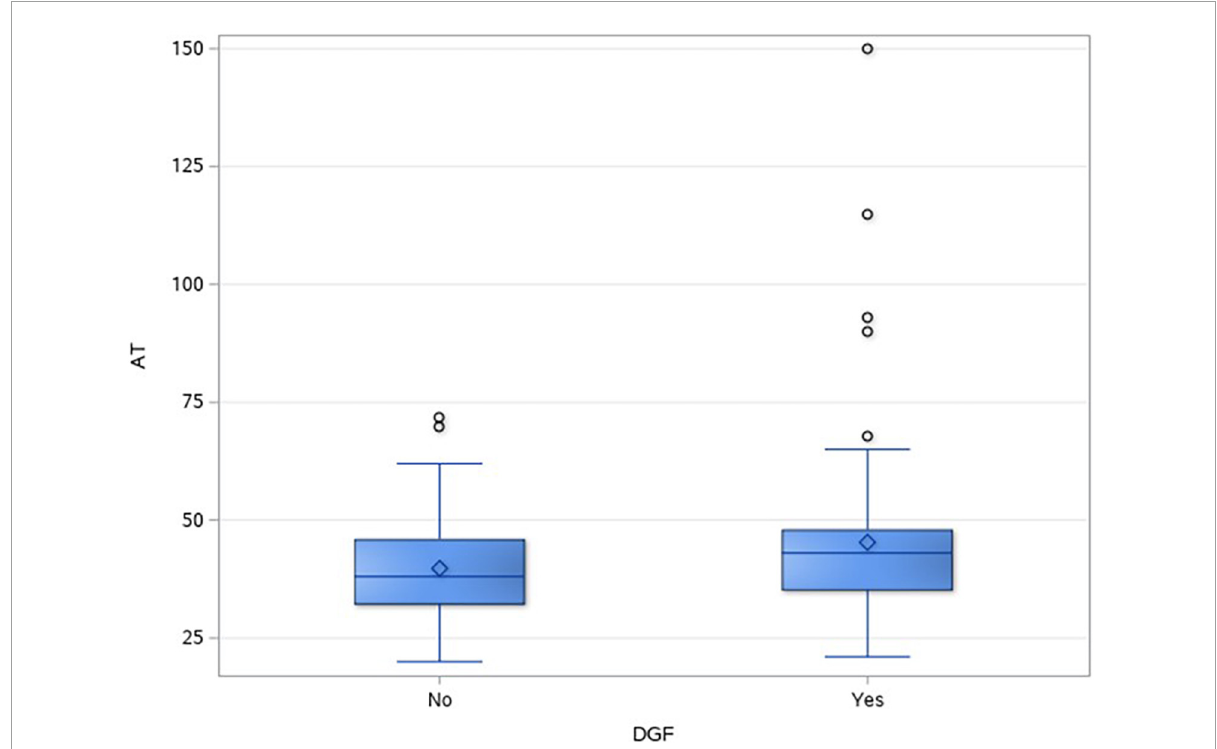
FIGURE2 Box and whisker plot showing the distribution of anastomotic time in the two groups.